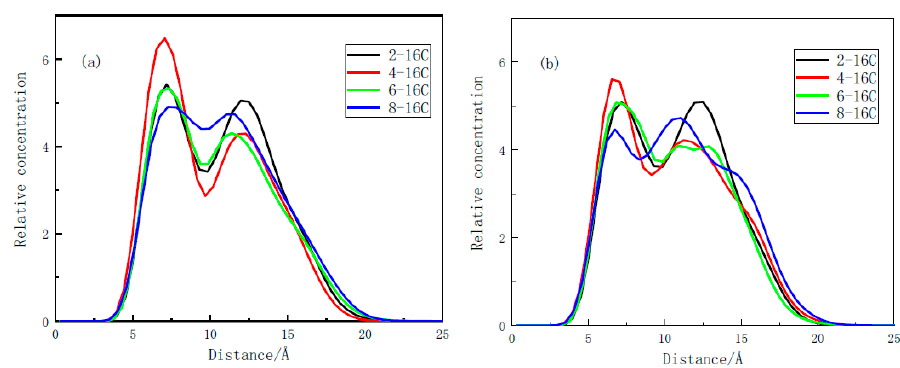
Figure 8. The relative concentration distribution of the four surfactants on ( a ) the hydroxyl group; ( b ) the ketone group along the Z axis.